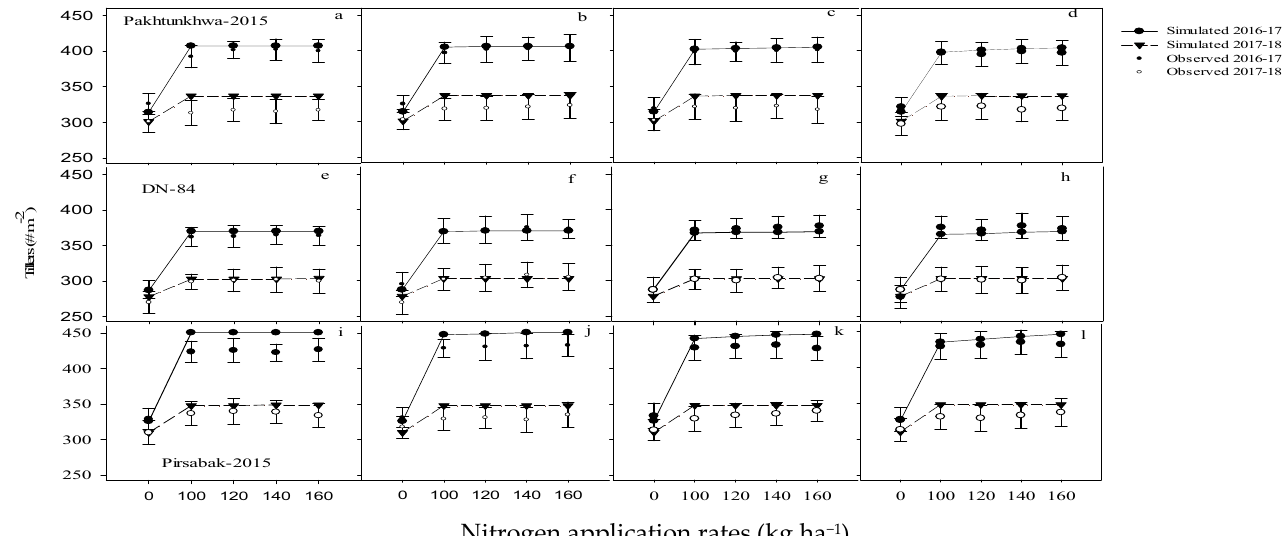
Figure 2. Simulated number of tillers (m − 2 ) as a function of N application at different stages: full N application (N 100% ) at sowing ( a , e , i ), half of recommended N application (N 50% ) at sowing + N 50% at tillering ( b , f , j ), quarter of recommended N application (N 25% ) at sowing + N 50% at tillering + N 25% at booting ( c , g , k ), and N 25% at sowing + N 25% at tillering + N 50% at booting stage ( d , h , l ) for different cultivars.